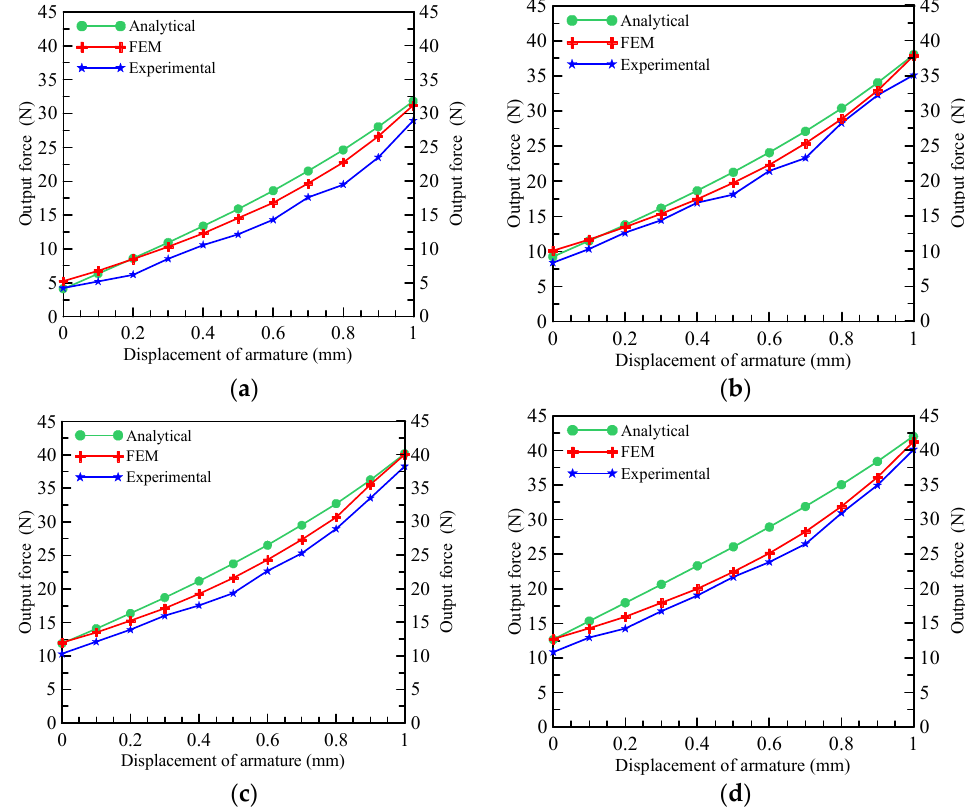
Figure 17. Force-displacement characteristic curve. ( a ) 0.5 A. ( b ) 1 A. ( c ) 1.5 A. ( d ) 2 A. Table 8. Summary of the magnetic flux density of 𝛿 (cid:2869) and 𝛿 (cid:2871) (x = 0.8 mm). Current/A 0.5 1.5 2